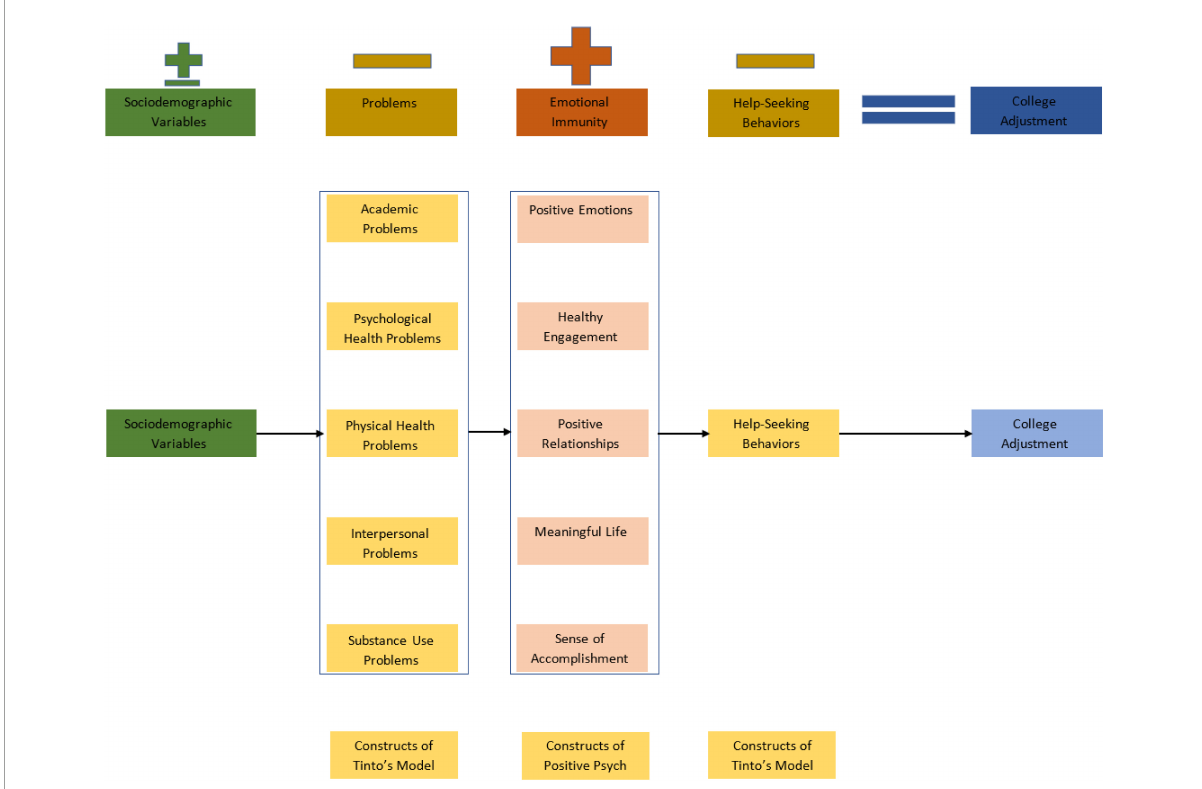
FIGURE2 Extended student retention model called “Integrative Positive College Adjustment Model”. ± Represents both positive and negative impact on college adjustment; + represents positive impact on college adjustment; – represents negative impact on college